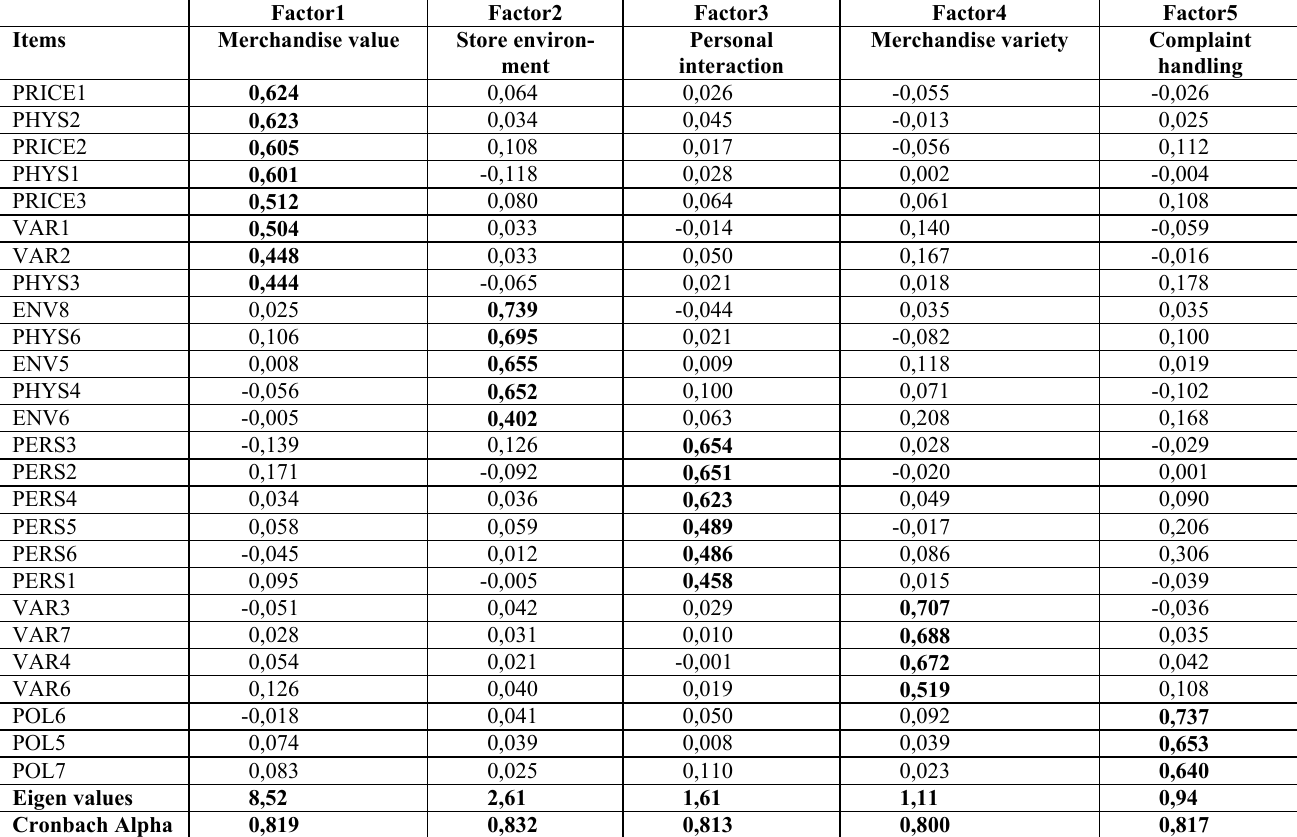
Table 2: Rotated factor loadings